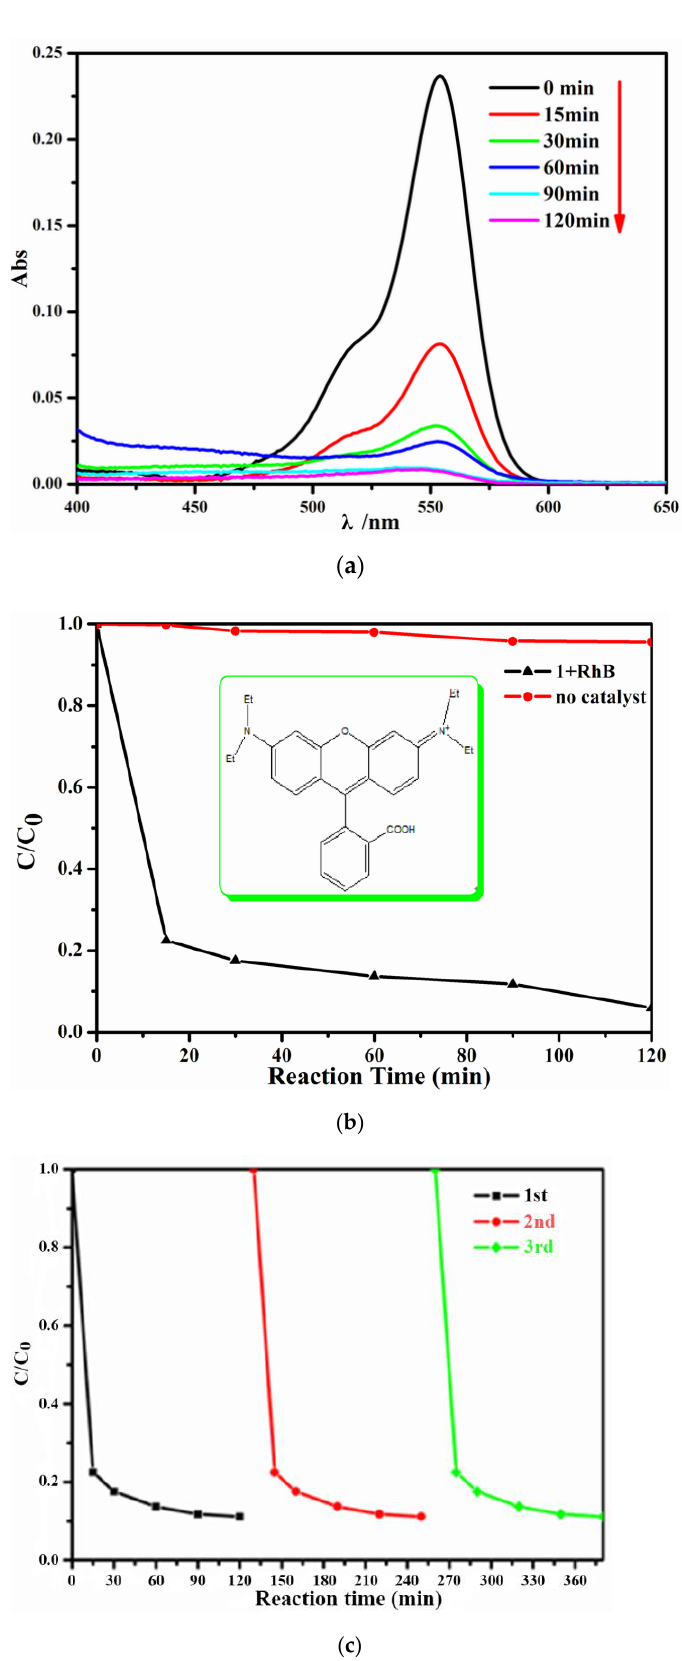
Figure 5. ( a ) Time-dependent UV−Vis spectra of RhB with the presence of 1 as catalyst; ( b ) Degradation ratio of RhB different irradiation time with or without the presence of catalyst; ( c ) Recycling tests of 1 for RhB photodegradation under light irradiation.